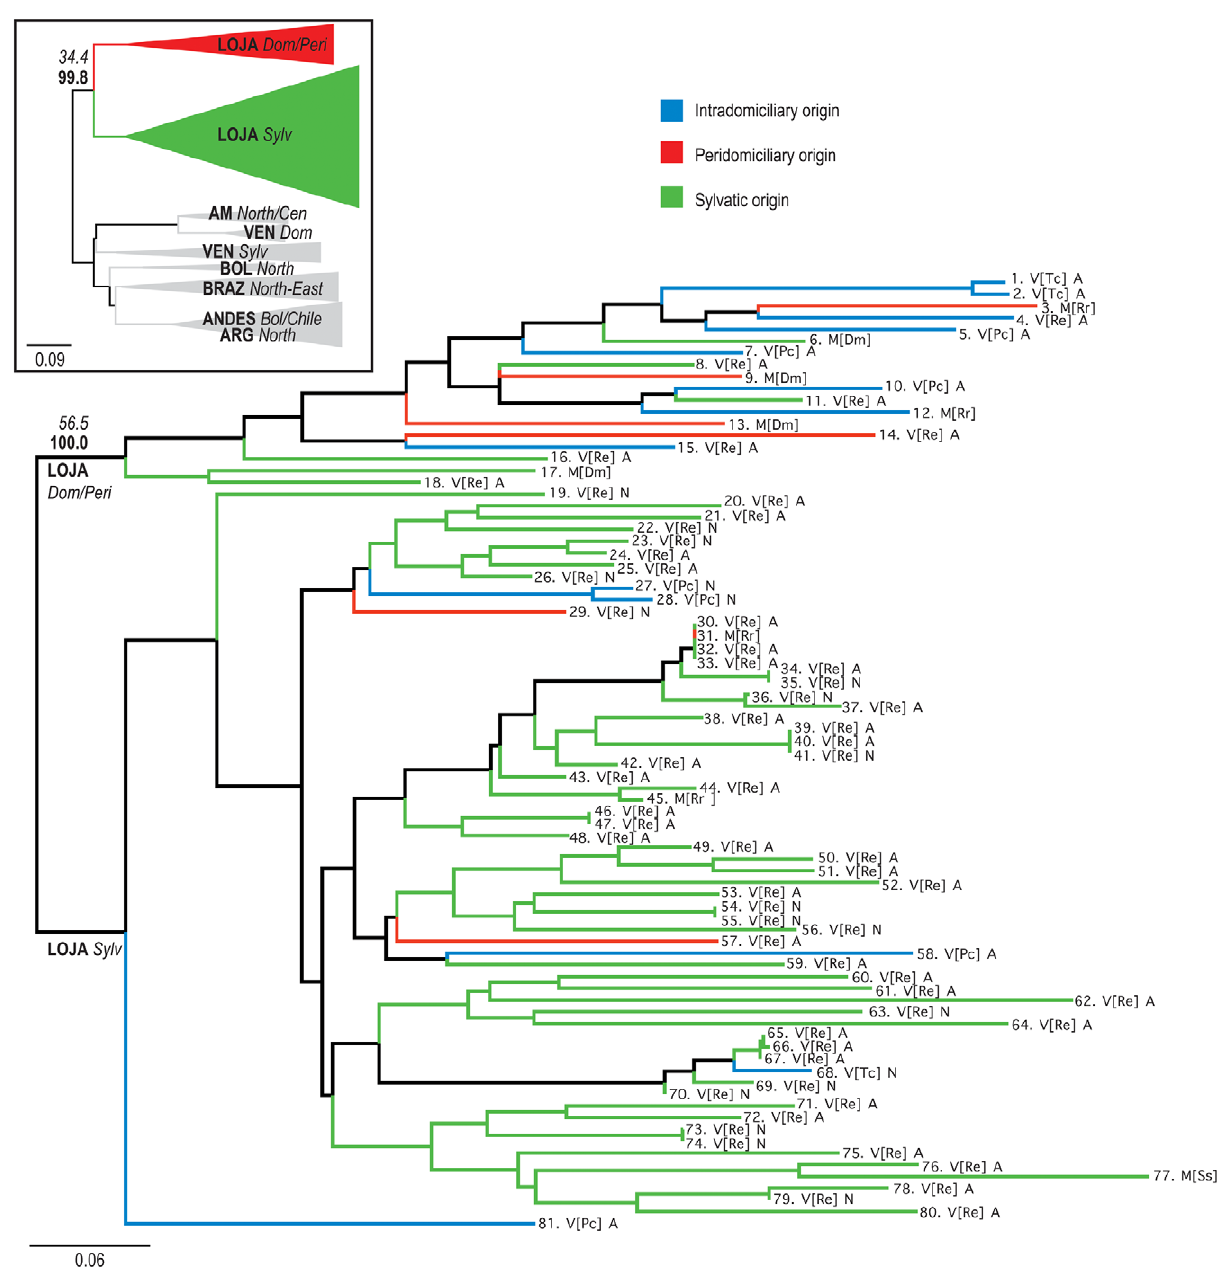
Figure 2. Neighbor-joining tree based on D AS values from 10 microsatellite loci. Continental-scale affiliations of Loja TcI strains are shown in the insert figure and the local subdivision between transmission cycles is shown in the main figure. T. cruzi D AS values correspond to the mean of 1,000 random diploid re-samplings of the dataset. Solid grey triangles indicate samples from other regions of South America while colored triangles indicate Ecuadorian populations ( LOJA Dom/Peri and LOJA Sylv ). Branch color codes indicate capture environment. Blue: domicile; Red: peridomicile; Green: sylvatic. Sample codes were defined as follows: M: mammal; Dm: Didelphis marsupialis ; Rr: Rattus rattus ; Ss: Sciureus stramineus ; V: vector; Pc: Panstrongylus chinai ; Tc: Triatoma carrioni ; Re: Rhodnius ecuadoriensis ; A: adult; N: nymph. Values in italics correspond to bootstraps (%) over 10,000 trees drawn from 100 randomly sampled diploid datasets. Values in bold correspond to topological stability (percentage congruent trees) over 1,000 randomly sampled diploid datasets (see Methods ). doi:10.1371/journal.pntd.0000915.g002 populations (Figure 2 and Table 1). No pattern or diversification lines of evidence: neighbor-joining analysis based on pair-wise by host or vector was observed within these populations. The genetic distance; model-based population assignment (STRUC- observed bipartite subdivision was unaffected by the presence of TURE); and the statistical significance of the fixation index F ST .The deepest and most robust (56.5%) internal branching multi-allelic loci (100% congruence, Figure 2) and was used as a means to define the populations examined in later analyses (See within the neighbor-joining tree constructed from pair-wise Table 1). Sample allocation between these two populations was genetic distance values ( D AS ) supported the delineation of two